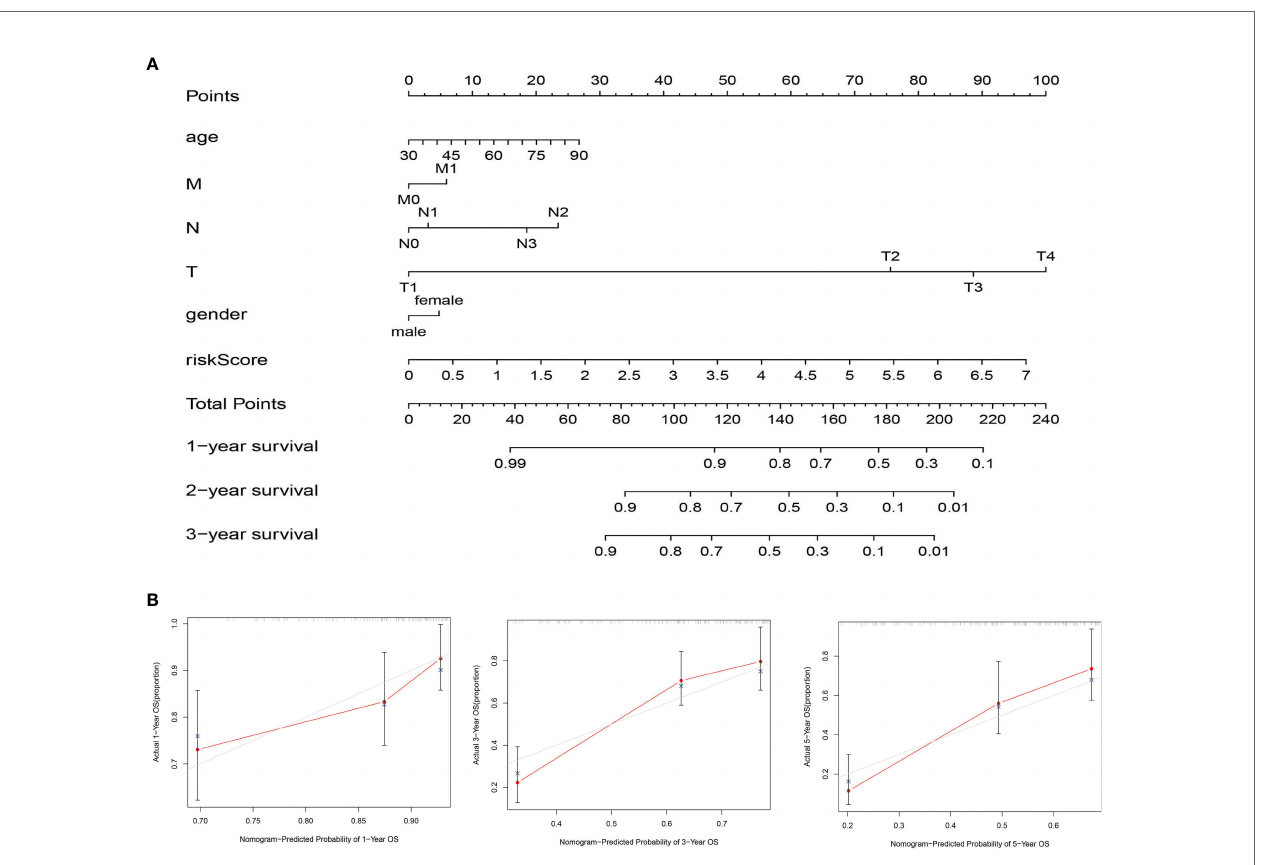
Frontiers in Oncology |